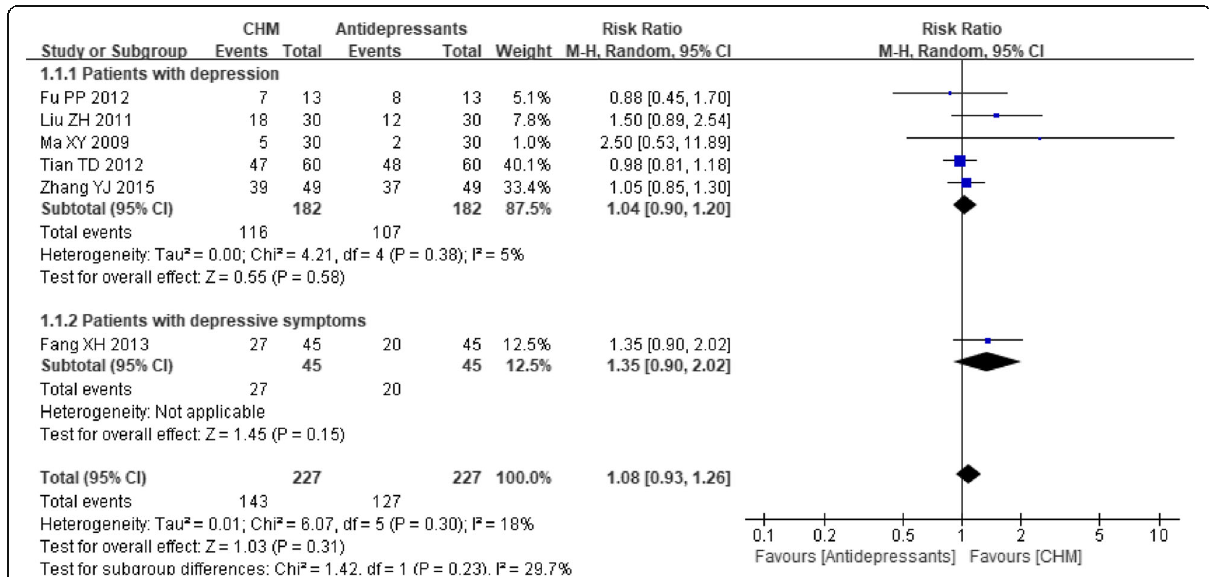
Fig. 7 Forest plot of the depression treatment response rate for CHM versus antidepressants